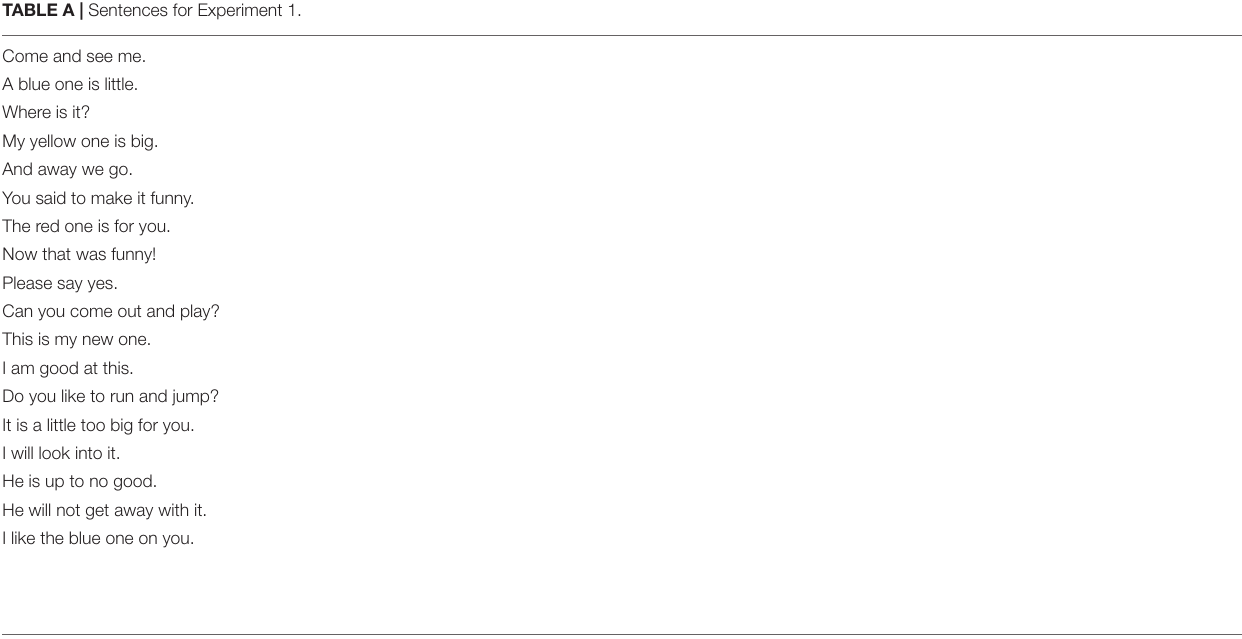
TABLE A | Sentences for Experiment 1.